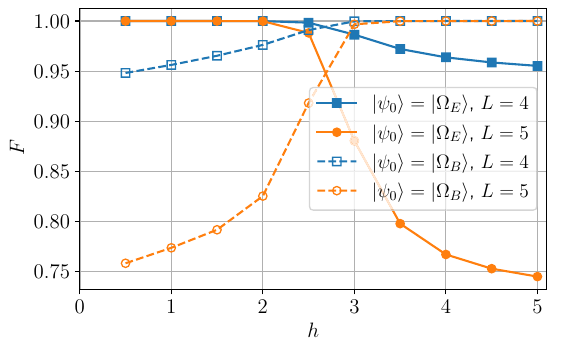
FIG. 9. Cruetz ratio χ( l , l ) , defined in Eq. (18), for two dif- ferent loops in a system with L = 5. Inset: expectation value of Wilson operators W l , l , corresponding to the data in the main plot, versus the coupling strength h . The vertical dashed line indi- cates the critical value of the coupling h c . All data refer to the best energy out of 20 BFGS local optimizations, with P = 6 and (cid:3) = | (cid:5) (cid:3) , | (cid:5) (cid:3) , performed on a system of linear size L = 5 | ψ 0 E B and initialized with the optimal parameters found for L =